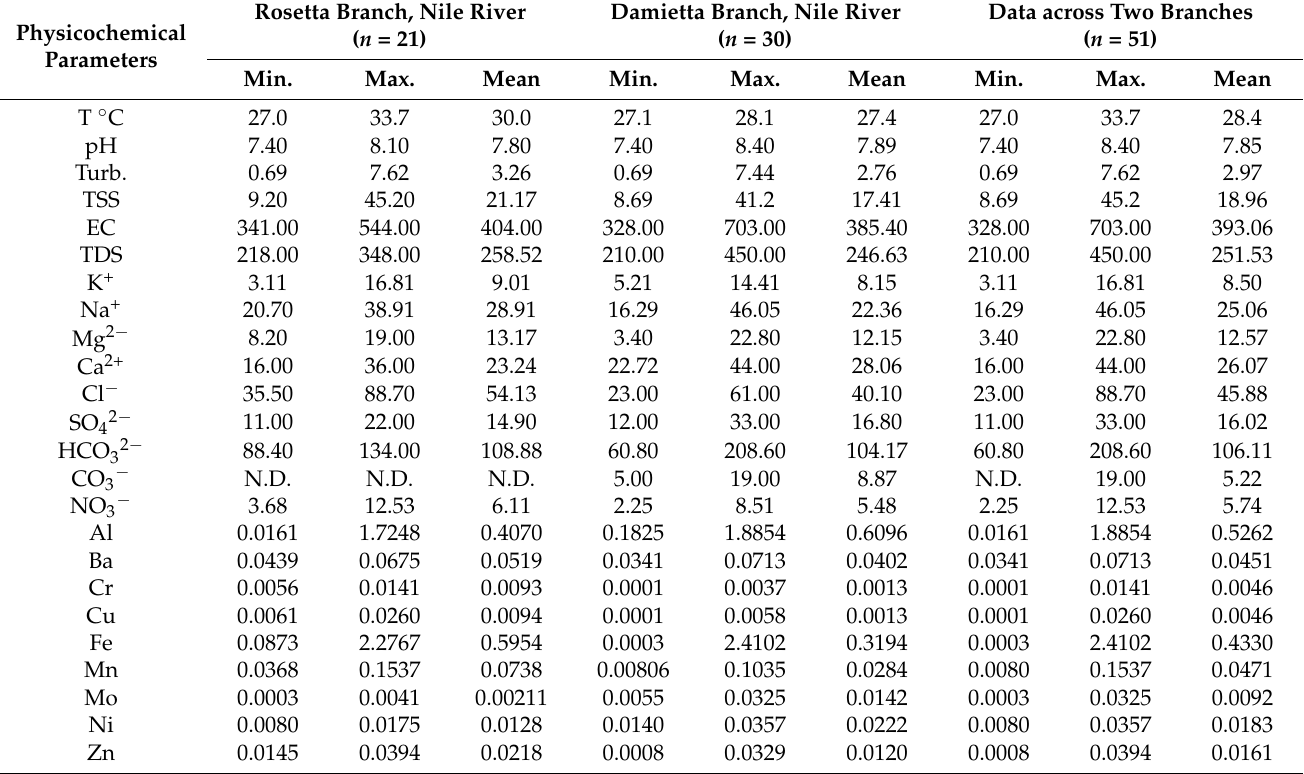
Table 4. Statistical analysis of the physical and chemical parameters of surface water samples from the Nile